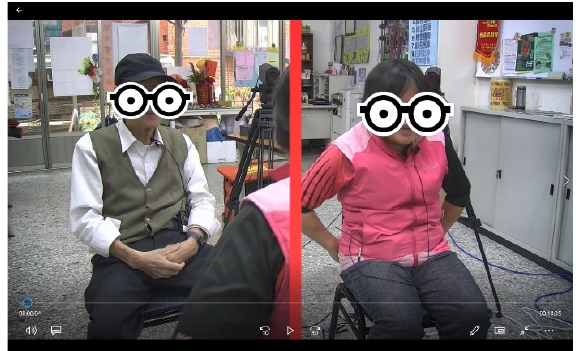
Figure 1. A Sample of Split-Screen Image.